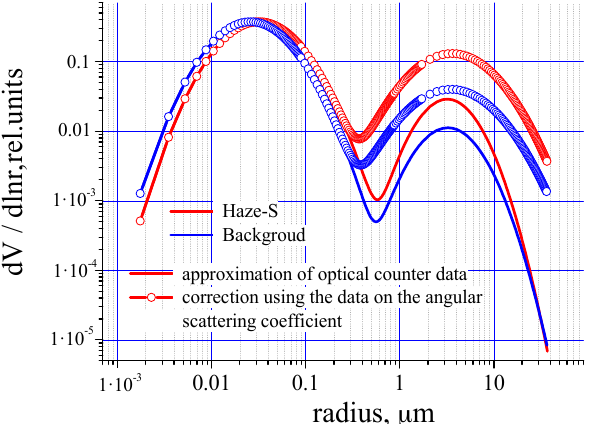
Figure 3. Volume distributions obtained according to the data from the optical counter and corrected according to the data of the angular scattering coefficients (summer). The red lines indicate the “Haze-S” weather type, the blue lines indicate the “Background” type, the solid lines are the approximation of the data from the optical counter, and the circles show the distributions after correction using the angular scattering coefficients.